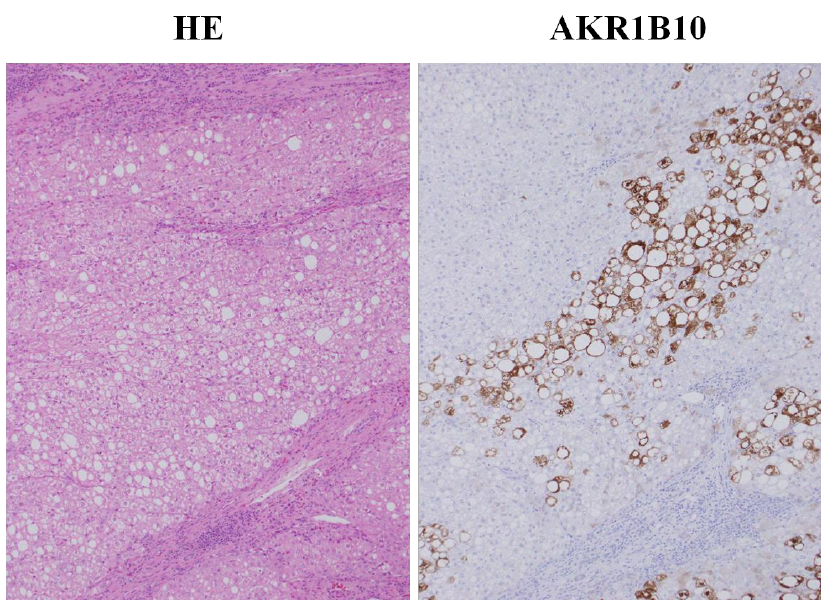
Figure 4. Representative immunostaining of AKR1B10 in hepatocytes containing fatty change. AKR1B10, aldo-keto reductase family 1 member B10; HE, hematoxylin-eosin. Original magnification